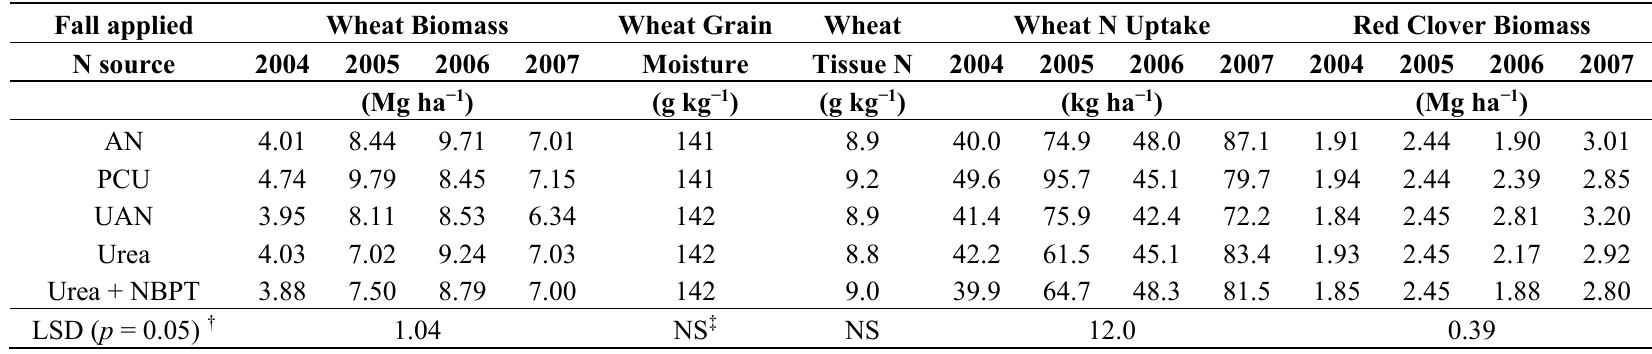
Table 2. Effect of fall-applied N sources on wheat plant biomass dry matter, grain moisture, tissue N, wheat N uptake, and frost-seeded red clover biomass dry matter; nitrogen sources included AN, ammonium nitrate; PCU, polymer-coated urea; UAN, urea ammonium nitrate; urea; and urea plus NBPT; data were averaged over N rates (0, 56, 84, and 112 kg N ha − 1 ) and years in the absence of a significant